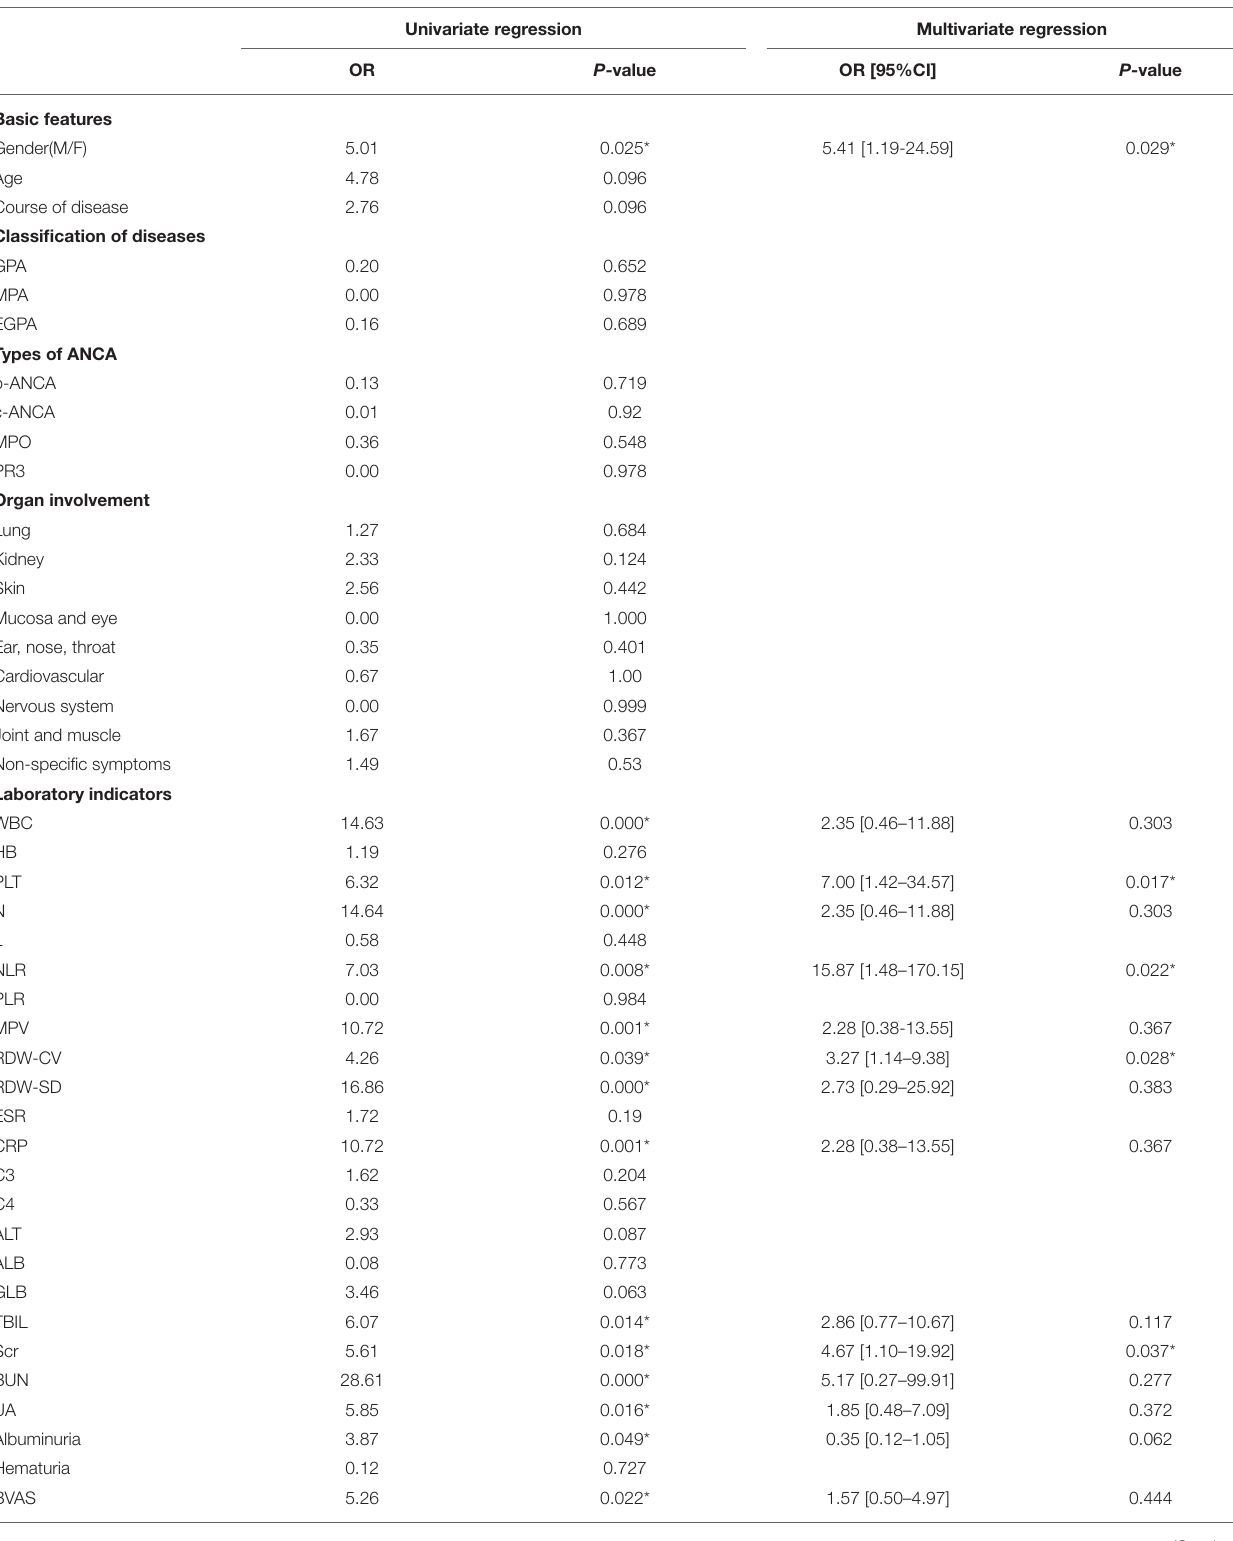
TABLE 2 | Factors related to 1-year mortality ratio in patients with AAV according to univariate regression and multivariate regression. Univariate regression Multivariate regression OR P -value OR [95%CI] P